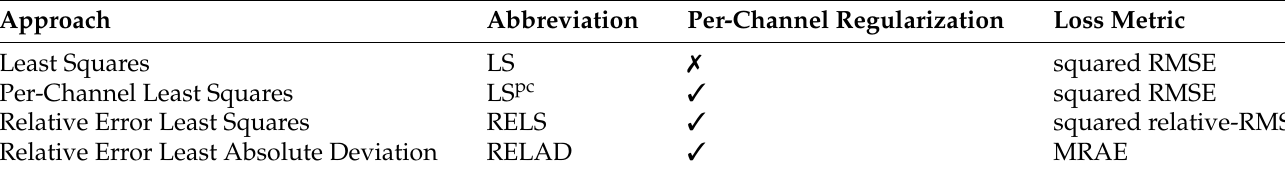
Table 2. List of minimization